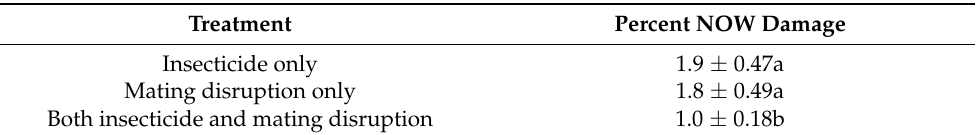
Table 3. Percent navel orangeworm damage (mean ± SE) from interior windrow samples, by insecticide and mating disruption treatment and across all varieties, 2006–2015.